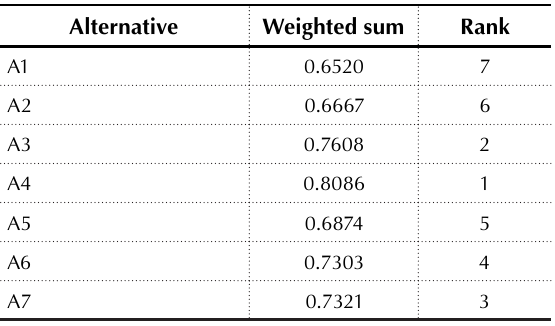
Table 5. Ranking alternative strategies for human capital development